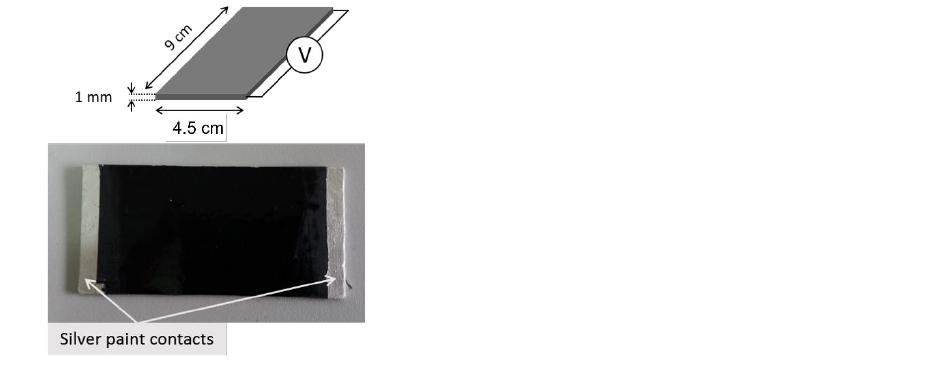
Figure 1. Specimen geometry for evaluating electrical and responsivity measurements.